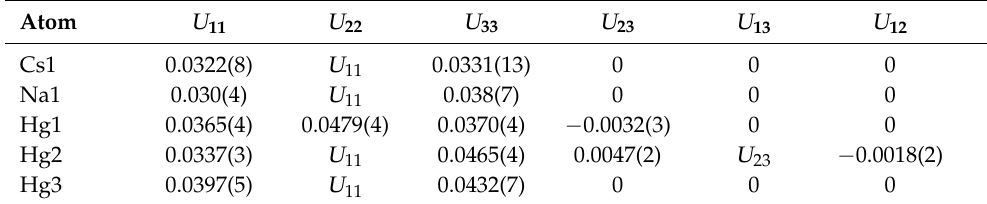
Table 4. Coefficients of the anisotropic displacement tensor (Å 2 ) for CsNa 2 Hg 18 . U ij is defined as